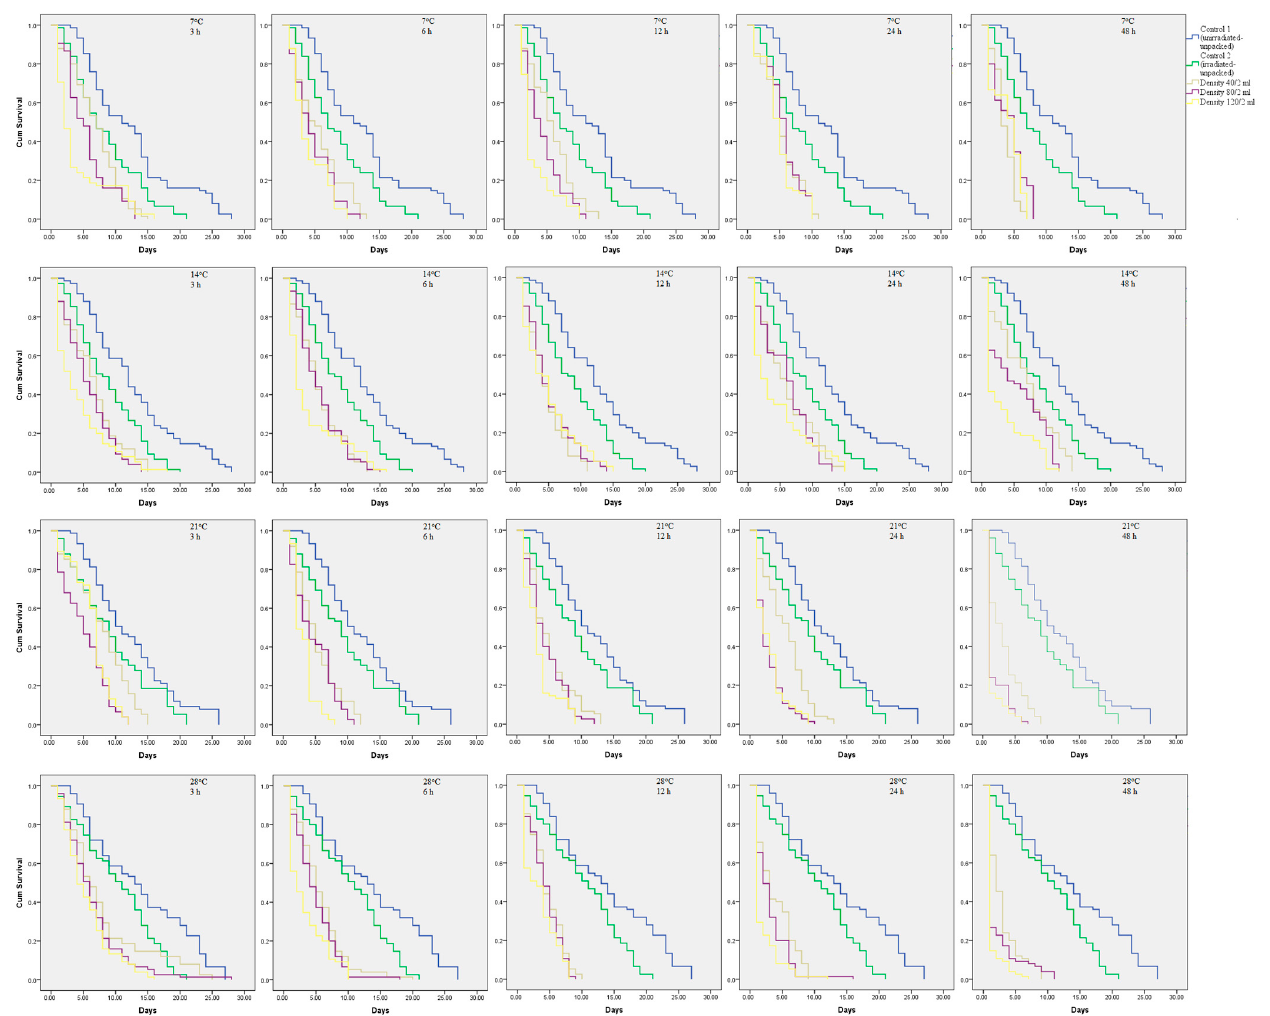
Figure 1. Kaplan–Meier survival curve of gamma-sterilized male Ae. aegypti post-treatment. X- and Y-axes represent days and cumulative survival, respectively. Blue, green, grey, purple, and yellow lines represent control 1 (unirradiated–unpacked), control 2 (irradiated–unpacked), and densities of 40, 80, and 120 males/2 mL,